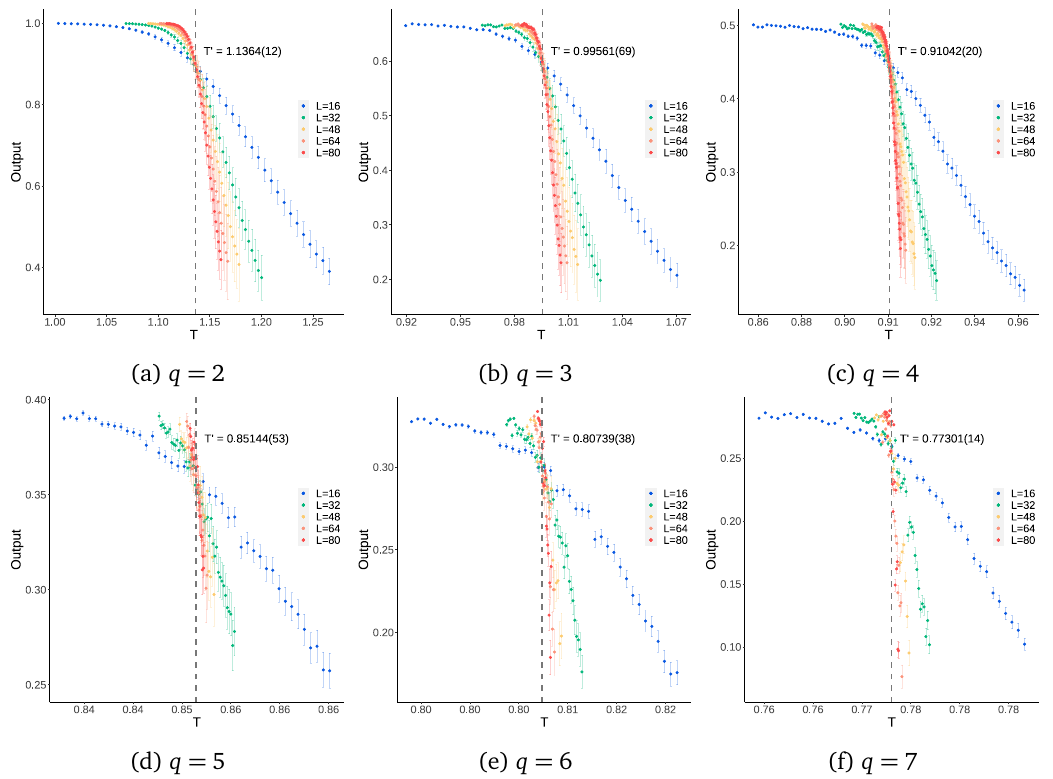
Figure 12: The relationship between temperature and the average output of an en- semble of 10 independently trained ANNs – training with simplified data, and testing with MC data of the ferromagnetic q -state Potts model on a square lattice. The error bars shown are 99.7% confidence intervals of the ensemble